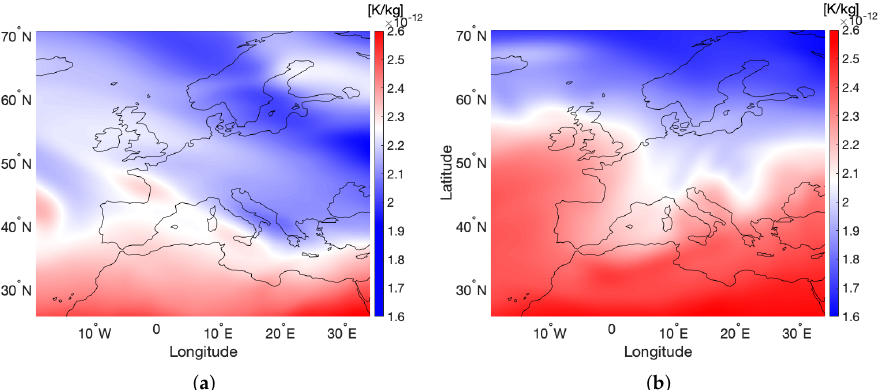
Figure 6. O 3 aCCFs [K/kg(NO 2 )] at 250 hPa at 0000 UTC for two days of ( a ) small variability (18 March 2016) and ( b ) large variability (1 March